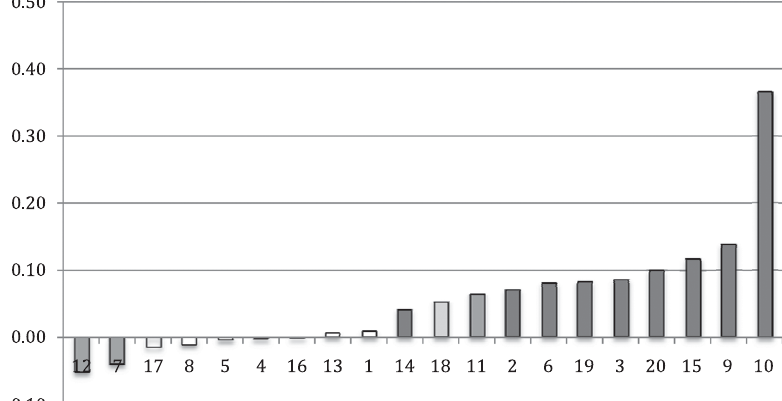
FIG. 2. Raw differences in average performance arranged in increasing order. The labels correspond to those in Tables I and II. Bars shaded dark gray, medium gray, and light gray indicate effects significant at the 1%, 5%, and 10% levels,